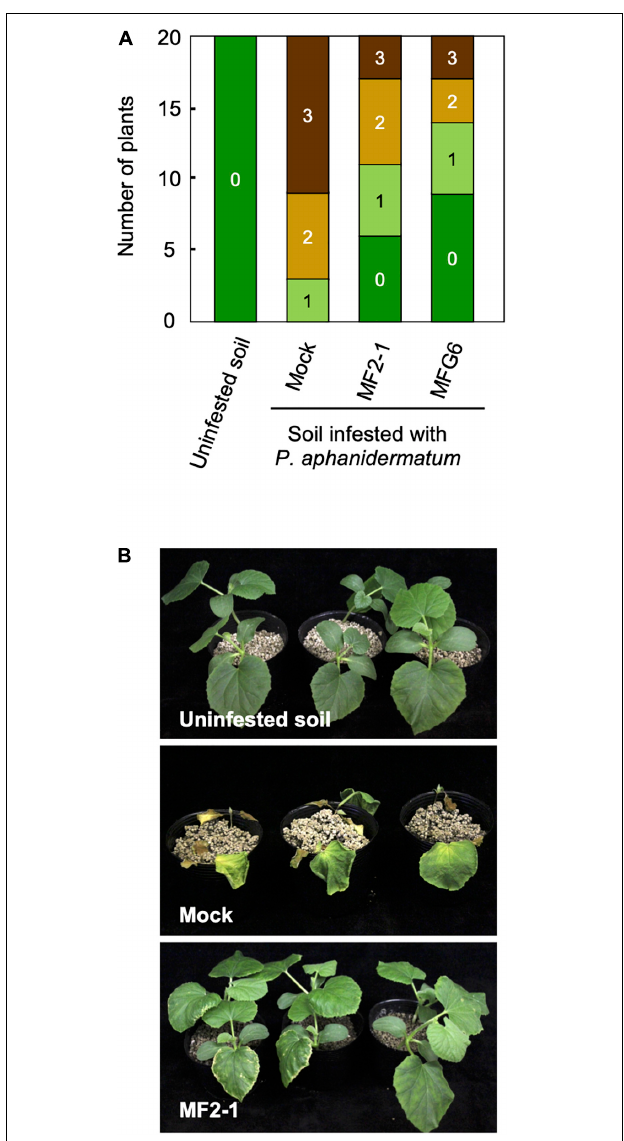
FIGURE 9 | Biocontrol activity of (cid:49) FOW2 strain of Fusarium oxysporum f. sp. melonis against Pythium aphanidermatum . Roots of melon seedlings were dipped in a conidial suspension (1 × 10 6 , 10 7 or 10 8 conidia/mL) of (cid:49) FOW2 strain MF2-1 or nonpathogenic strain MFG6, and seedlings were planted in soil infested with P. aphanidermatum (1 × 10 5 oospores/g soil). Control seedlings were immersed in water and planted in uninfested or infested soil (Mock). (A) Symptoms were scored 21 dpi as 0, no symptoms; 1, yellowing; 2, wilted; 3, dead. (B) Plants at 21